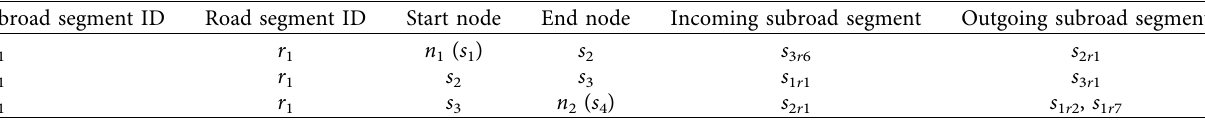
Table 1: Illustrative table of road network topology.